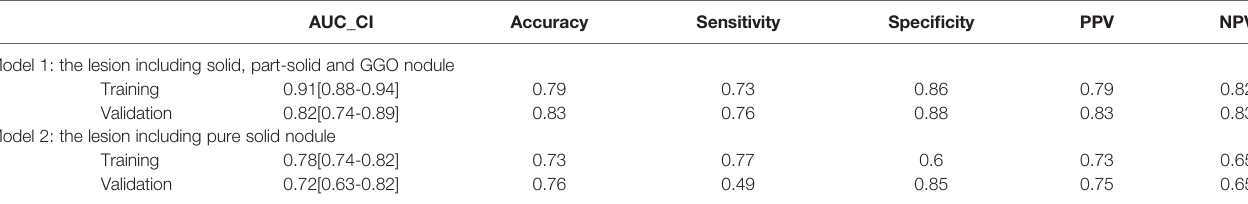
TABLE 5 | Predictive probabilities for the two radiomic model on the training and validation cohort.